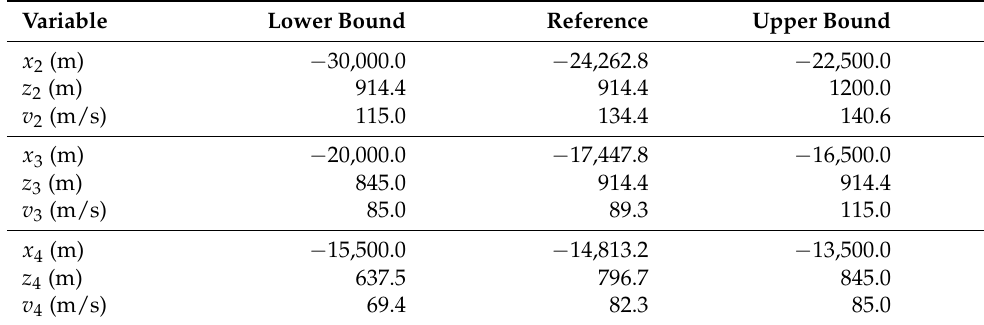
Table 7. Approach manoeuvre optimisation variables for the twin-aisle aircraft: reference values with upper and lower